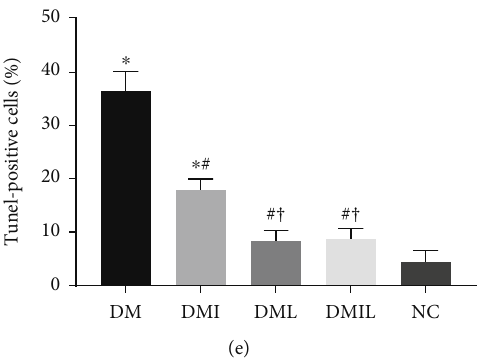
Figure 2: E ff ects of liraglutide on hepatocyte apoptosis in DM mice. (a) Relative mRNA expression of Bcl-2, Bax, and caspase-3 in liver tissues was assessed by quantitative RT-PCR. (b, c) Representative Western blot images and densitometry measurements of Bcl-2, Bax, and caspase-3 expressions in liver tissues. (d) Representative immuno fl uorescence images of TUNEL-stained liver tissue sections. (e) Percentage of TUNEL-positive cells. Data are expressed as mean ± SD ( n = 4 /group); p < 0 : 05 was de fi ned as statistically signi fi cant. Scale bar is 200 μ m in the images. DM: saline-treated type 1 diabetes group; DMI: insulin treatment group; DML: liraglutide treatment group; DMIL: insulin+liraglutide treatment group; NC: normal glucose tolerance group; ∗ : compared to NC; #: compared to DM; † : compared to DMI; ‡ : compared to DML; Bax: Bcl-2-associated X protein; RT-qPCR: reverse transcription quantitative real-time polymerase chain reaction; TUNEL: terminal deoxynucleotidyl transferase- (TdT-) mediated dUTP nick-end labeling.